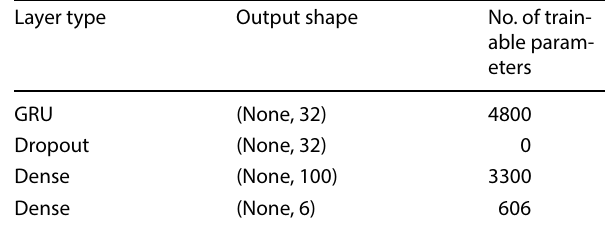
Table 5 GRU network design